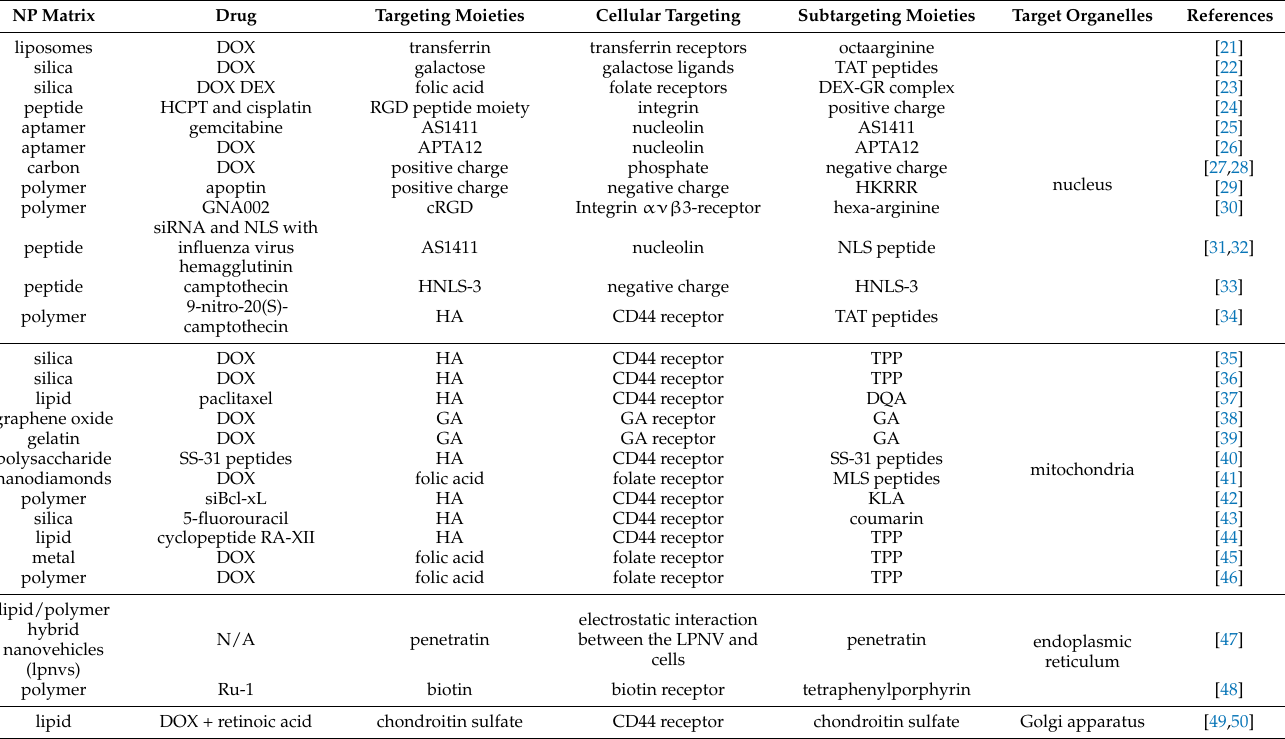
Table 1. Some physical and bioactivity characteristics of sequential-targeting drug delivery